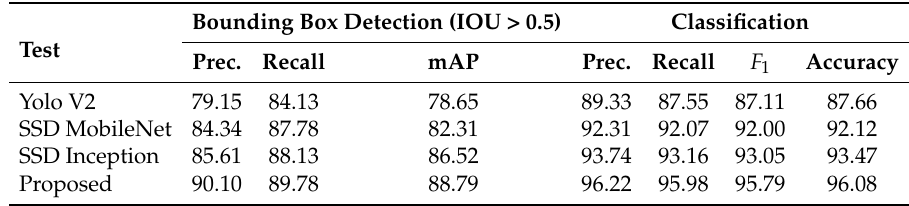
Table 4. Comparison with other frame work using bounding box detection and classification